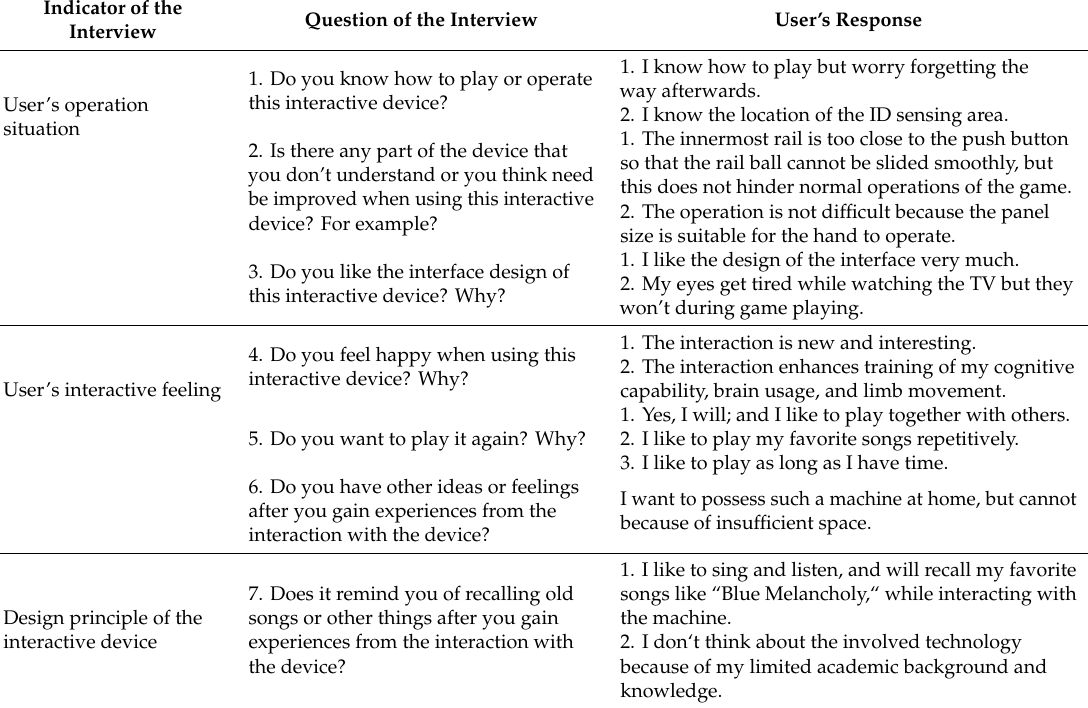
Table 6. List of the questions used in interviews with the older adults using the proposed